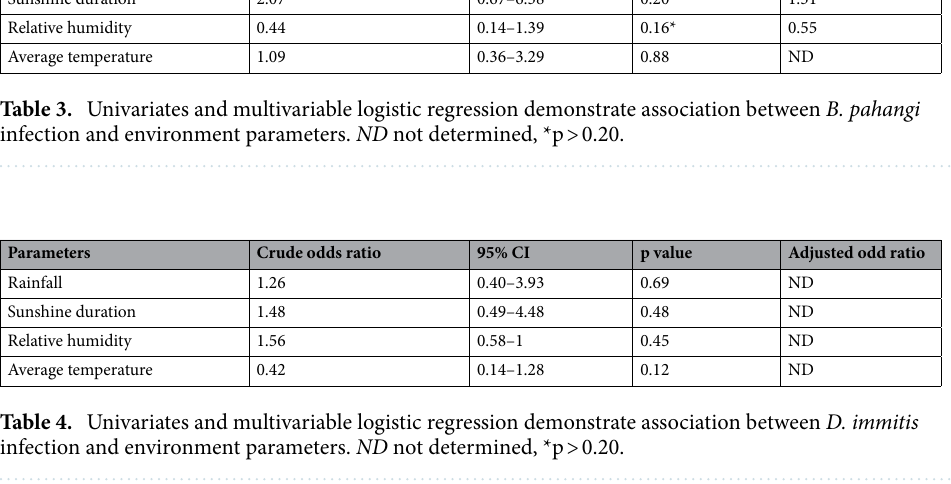
Parameters Crude odds ratio